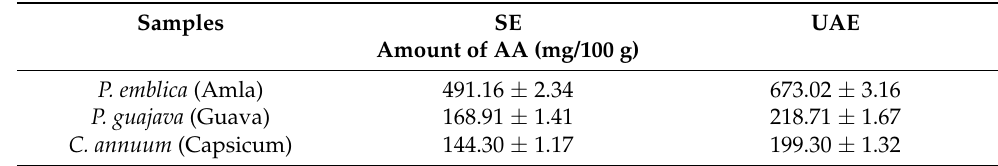
Table 6. Application of the greener HPTLC method for the estimation of AA in the SE and UAE of